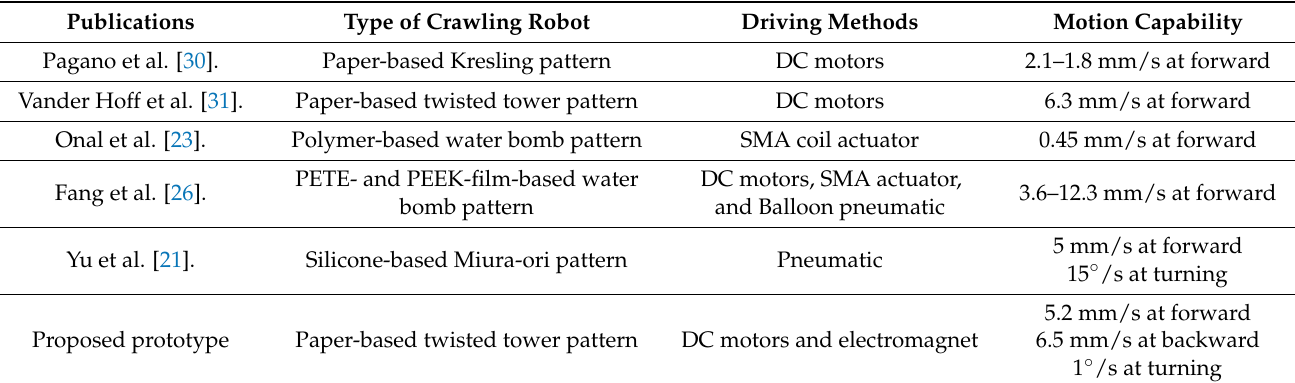
Table 6. Comparison of motion capability of different origami crawling robot